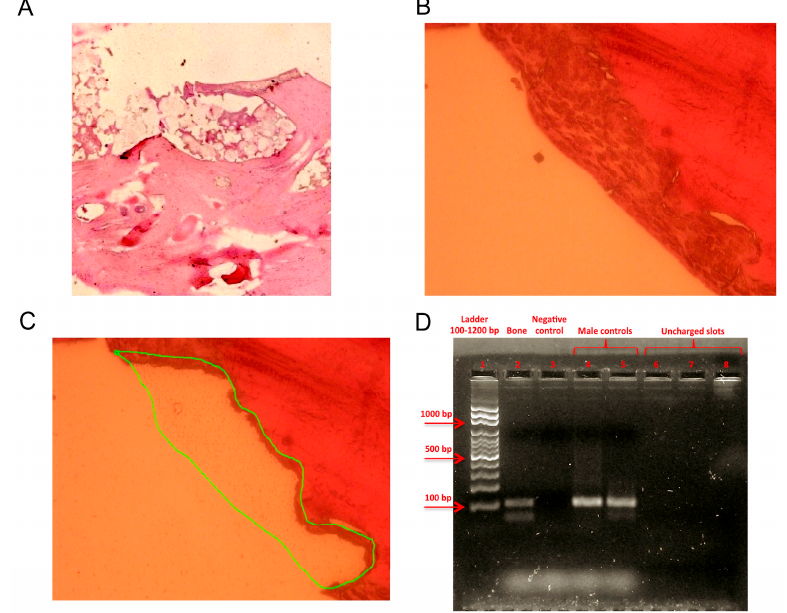
Figure 1. Bone sample characterization. ( A ) Microscopy image (hematoxylin and eosin staining) showing the features typical of bone tissue and inflammatory infiltration; example of a laser captured microdissected area of the bone sample: ( B ) shows the pre-microdissected area (40 × resolution); ( C ) the green line encircles the microdissected area; ( D ) sex-determining region Y amplification revealed the sex of the patient: lane 1: ladder (100–1200 bp); lane 2: sample; lane 3: negative control; lanes 4 and 5: male controls; lanes 6–8: uncharged slots.